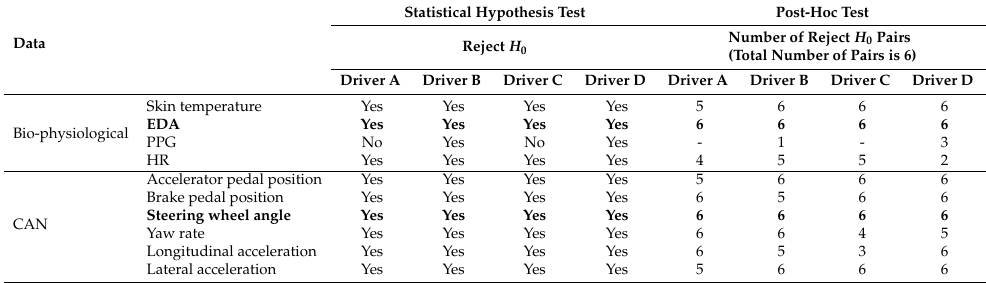
Table 4. Statistical hypothesis test results of structured data by self-reported emotion label according to driver.